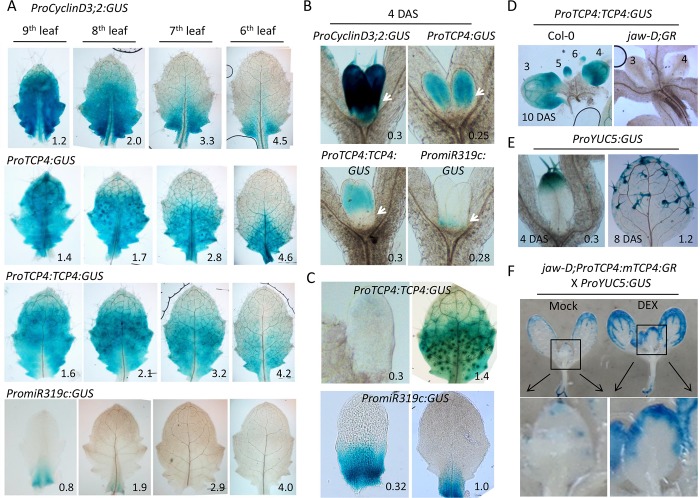
Spatio-temporal expression analysis of miR319-TCP4 module.(A) and (B) GUS reporter analysis in young leaves of 19-day old seedlings (A) and in the first leaf pair in 4-day old seedlings (B). White arrows point to the leaf base. (C) GUS activity in the fifth leaf at two developmental stages. (D) ProTCP4:TCP4:GUS activity in 10-day old mock grown Col-0 and jaw-D;GR seedlings. (E) and (F) GUS activity of YUC5 promoter in the first leaf (E) and in 5-day old seedlings grown in the absence (Mock) or presence (DEX) of 12 μM dexamethasone (F). The boxed regions in the top panel of (F) are magnified below to highlight GUS activity in the first leaf. Numbers indicate leaf length in mm (A) (B) (C) and (E) or leaf position (D).